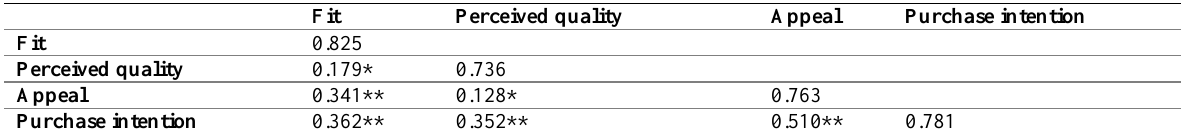
Figure 2: Diagram of confirmatory factor analysis Table 7: Discriminant validity